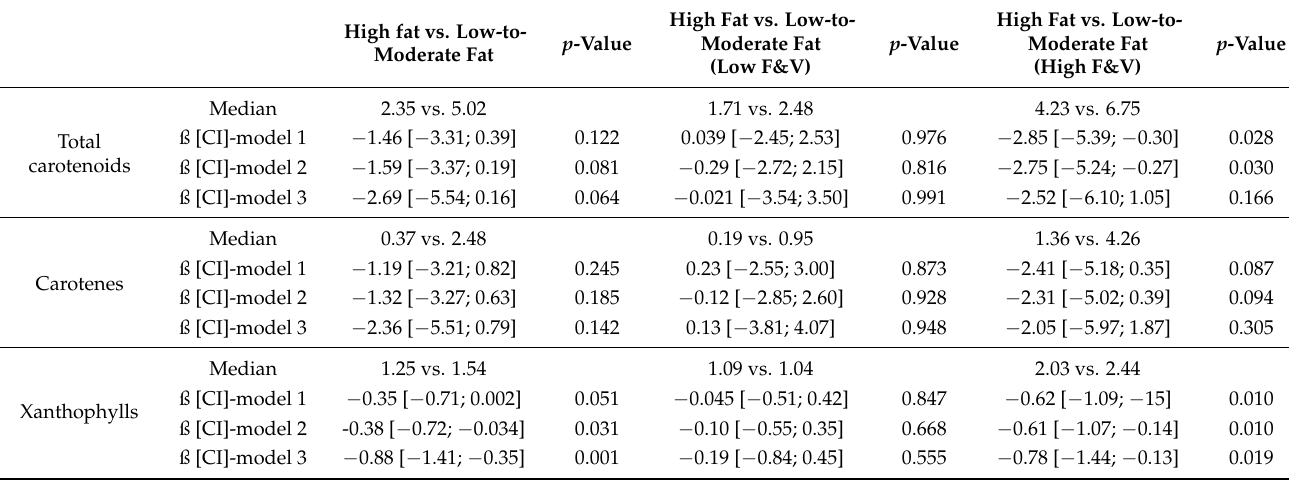
Table 3. Differences in total carotenoid, carotenes and xanthophylls plasma concentrations ( µ mol/L) between fat intake groups. High fat vs. Low-to- Moderate Fat